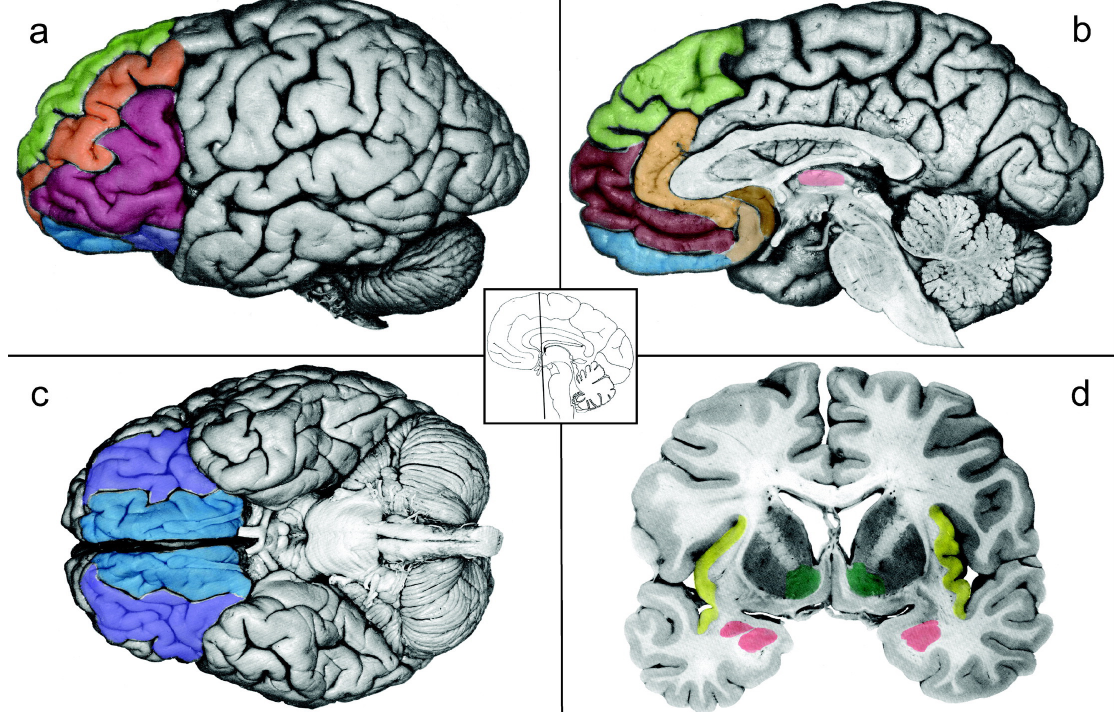
Figure 2. The areas involved during aesthetic judgment [40]. They are the areas that compose the prefrontal brain circuitry. Figure 2 highlights the cortical components [41]. The ventral system includes two closely-connected circuits that are anchored in the orbitofrontal cortex (OFC; c ). The sensory system involves the lateral sector of the OFC ( a , c , purple). It is closely connected to the anterior insula ( d , yellow) and the basolateral complex in the amygdala ( d , rose, ventral aspect). The visceromotor circuitry includes the ventral portion of the ventromedial prefrontal cortex, which lies in the medial sector of the OFC ( a – c , blue) where the medial and lateral aspects of OFC connect; the ventromedial prefrontal cortex is closely connected to the amygdala (including the central nucleus, d , rose, dorsal aspect) and the subgenual parts of the anterior cingulate cortex on the medial wall of the brain ( b , copper and peach). The dorsal system is associated with mental state attributions including the dorsal aspect of the ventromedial prefrontal cortex corresponding to the frontal pole ( b , maroon), the anterior cingulate (2 b , peach), and the dorsomedial prefrontal cortex (2 a , b , green). The ventrolateral prefrontal cortex is shown in red ( a ). Structures in the reward circuitry include the OFC, dorsolateral prefrontal (2 a , orange) and cingulate cortex ( b , copper and tan), the thalamus ( b , light pink), the ventral striatum d , green), the amygdala ( d , rose), the hippocampus ( d , gray), and the limbic